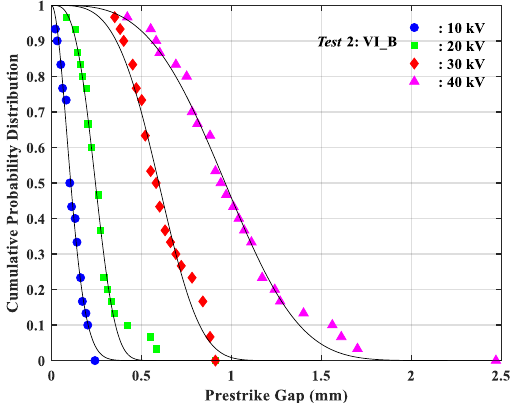
Figure 5. The complementary cumulative distribution function of prestrike gaps in Test 2.